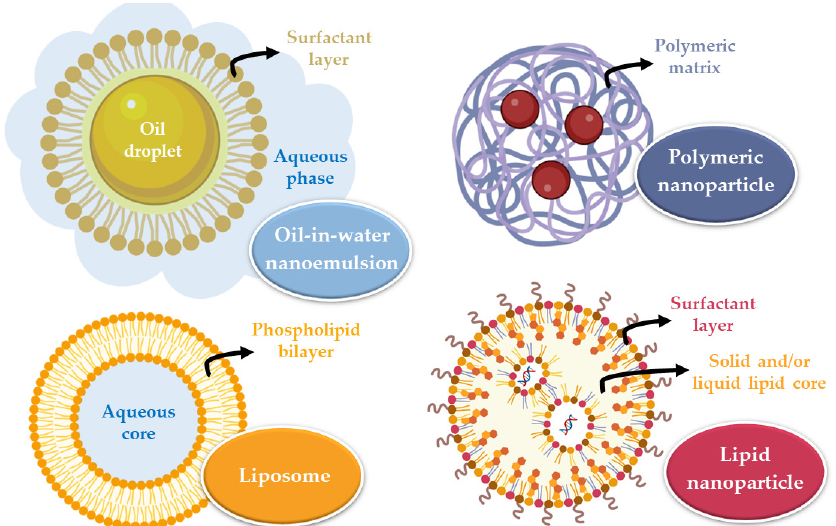
Figure 2. Main types of nanometric systems: liposomes, nanoemulsions, polymeric nanoparticles, and lipid nanoparticles.